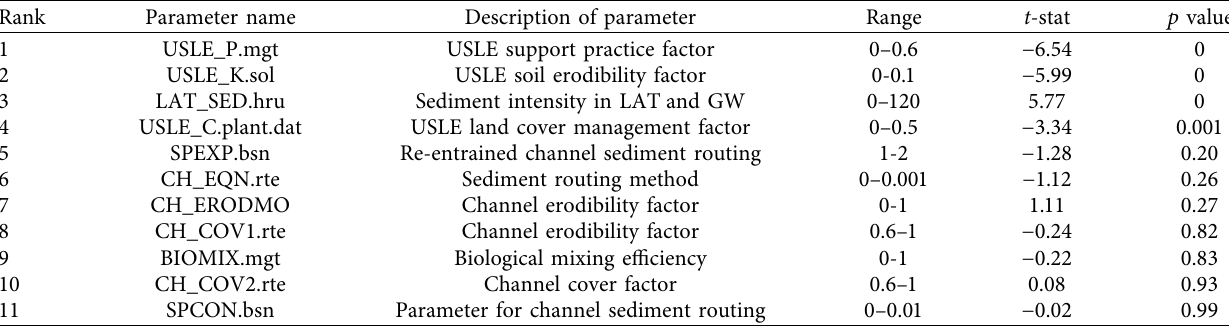
Table 8: Sediment calibration parameters and their sensitivity ranks.